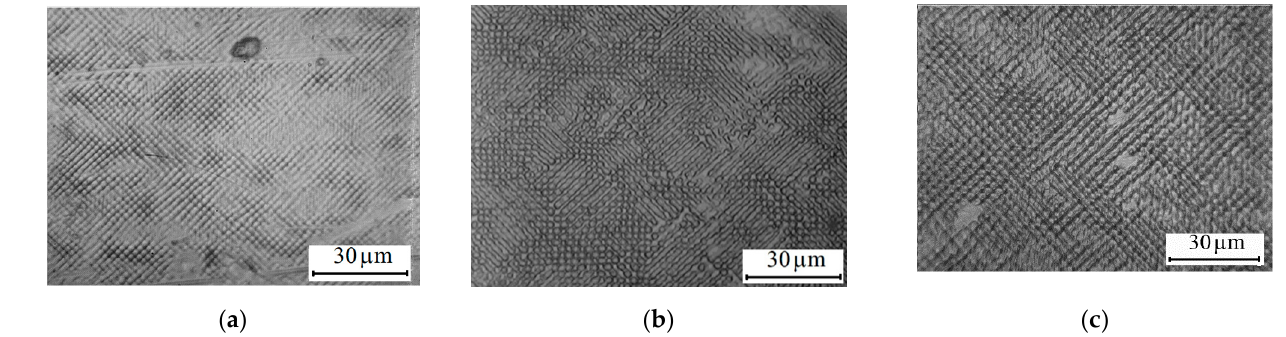
Figure 1. Tweed structure on (100)[001] Al single crystal foils after cyclic deformation at temperatures of 233 K ( a ), 296 K ( b ), and 363 K ( c ).